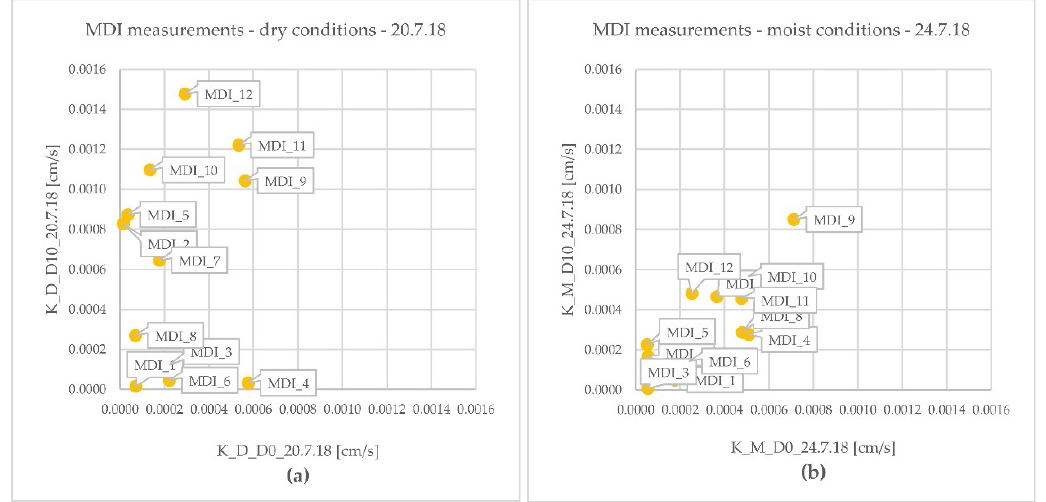
Figure 5. Scatter plots of MDI measurements conducted on the ground and in the pit. ( a ) K_D_D0_20.7.18; ( b ) K_M_D0_24.7.18.